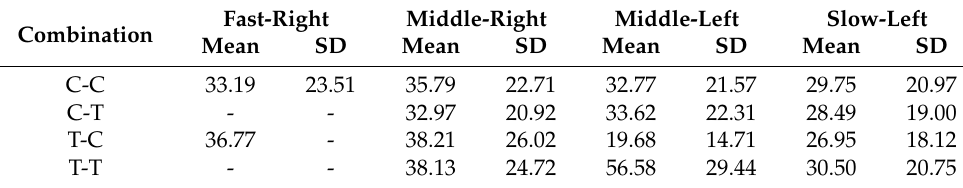
Table A10. The mean and standard deviation of TTC of m and n3. Fast-Right